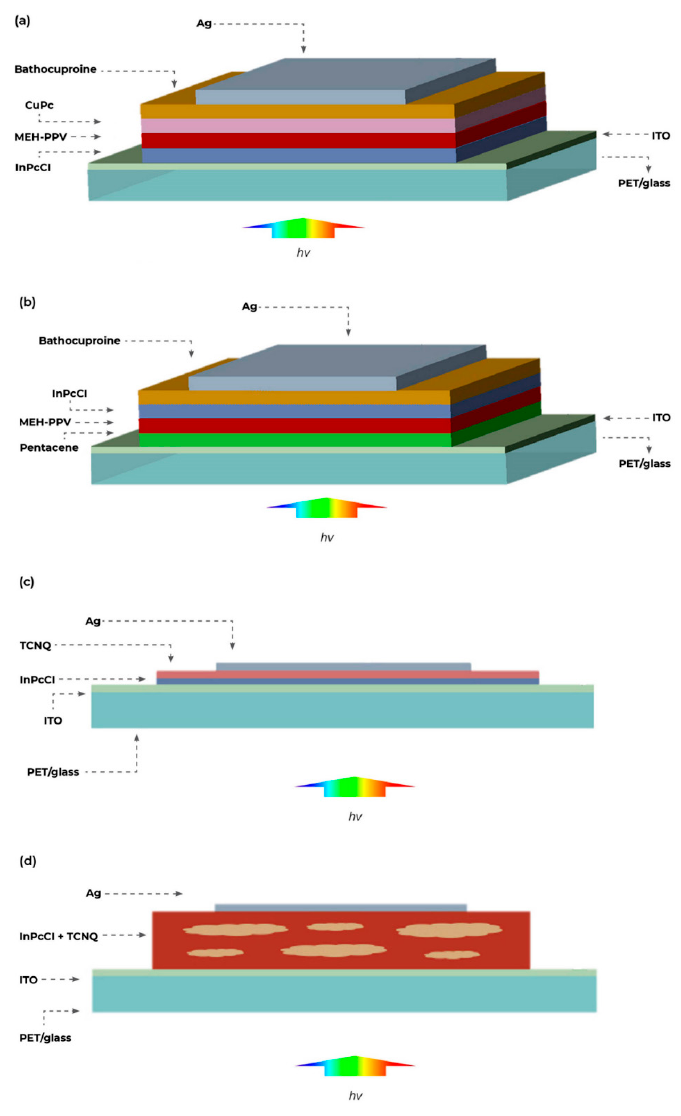
Figure 5. Structure of ( a ) D1 , ( b ) D2 , ( c ) D3 and ( d ) D4